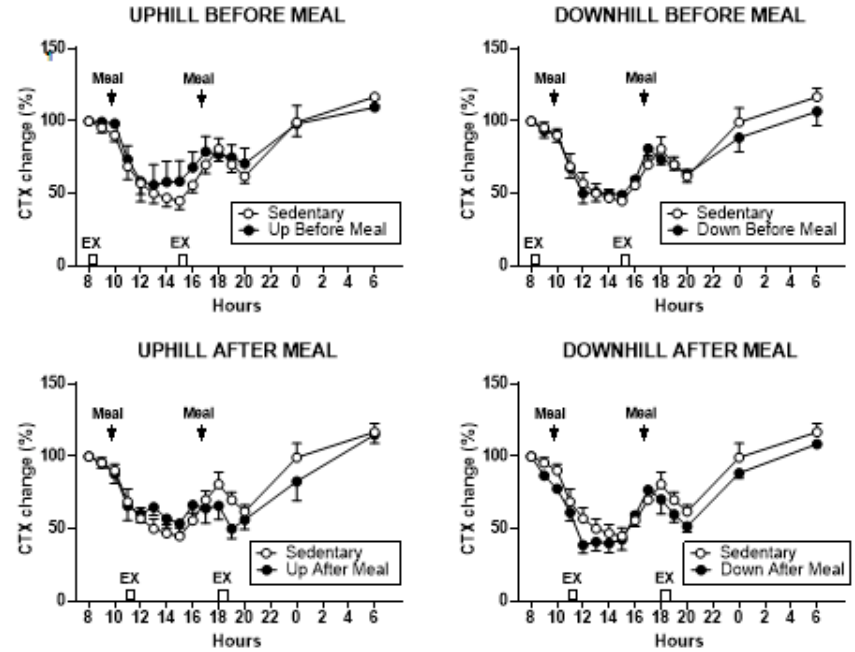
Figure 4. Percent changes in serum C-terminal telopeptide of type-I collagen (CTX) between sedentary trial and exercise trials performed before meals is shown at the top (left: UBM, right: DBM), and after exercise trials performed after eating, is shown at the bottom (left: UAM, right: DAM).